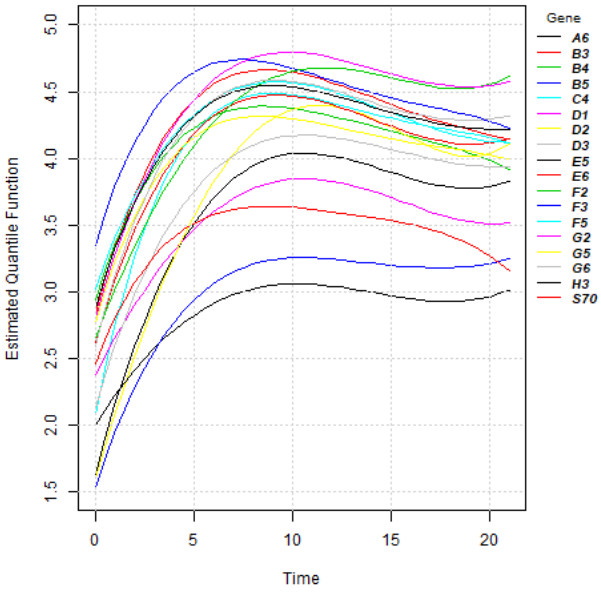
Figure 19. Estimated median functions of 18 genes in P. aeruginosa